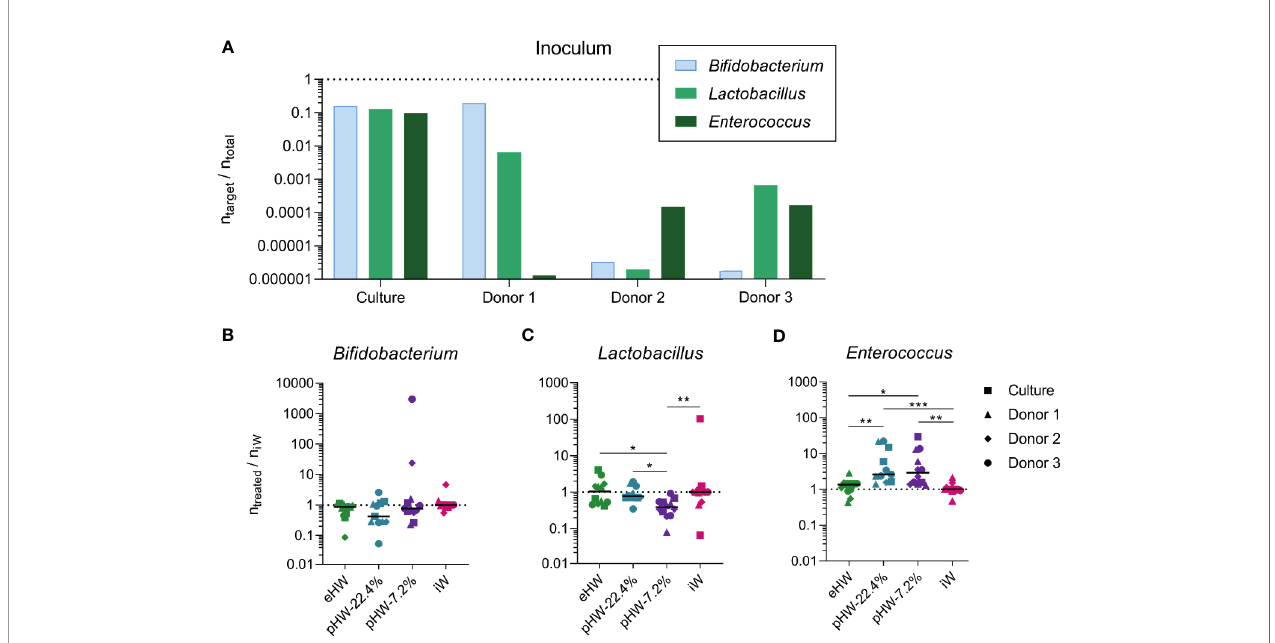
FIGURE 8 | Effect of whey products on in vitro expansion of bacterial genera derived from healthy infants. The relative abundance of selected bacterial genera before (A) and after (B – D) in vitro incubations supplemented with extensively (eHW), partially hydrolysed (pHW-22.4% or pHW-7.2%) or intact (iW) whey products. The results after in vitro incubations (B – D) are normalised to the median of the iW group. Each bar represents one donor/culture (A) , each symbol represents an in vitro incubation replicate, which is the average of three technical qPCR replicates and horizontal lines indicate median values (B – D) . The symbol shape indicates the inoculum source. Statistically signi fi cant differences between groups are indicated as *p ≤ 0.05, **p ≤ 0.01, ***p ≤